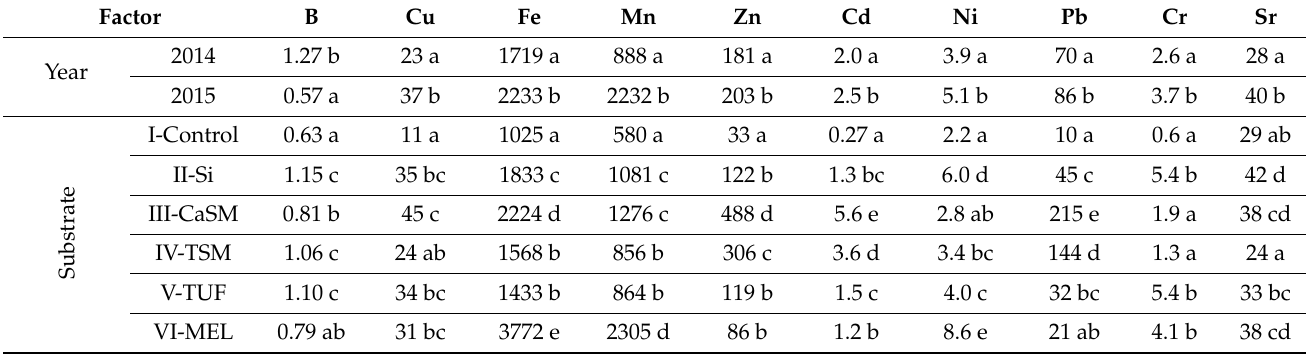
Table 8. Trace elements (mg kg − 1 ) content estimated after one- or two-year growth of Sedum acre L. in the substrates. Factor B Cu Fe